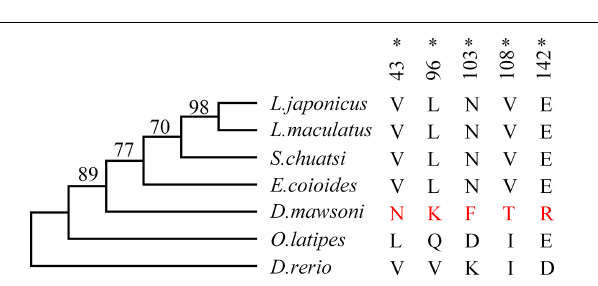
FIGURE 3 | Positive selection analysis. Numbers at the branches indicate the bootstrap support. Amino acids marked in red are positive selection sites for D. mawsoni , * P <